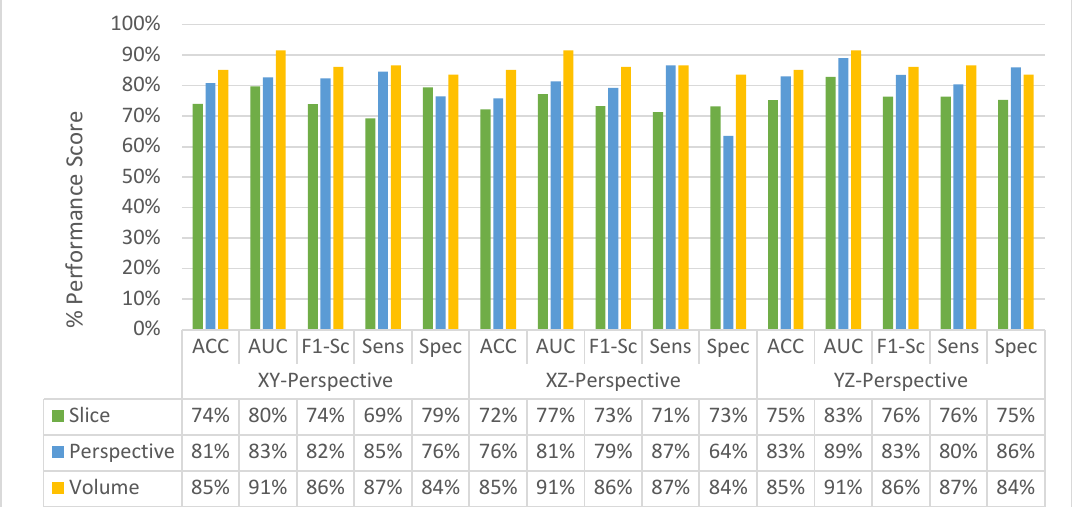
Figure 21. SFMPF model using Trilateral image—change in classification performance for slice, perspective, and volume-level classifications for each perspective.